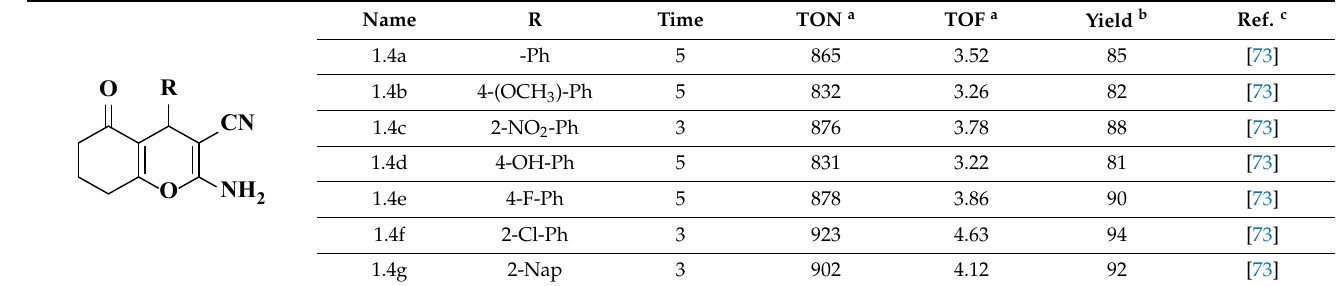
Table 2. Scope of different substrate.